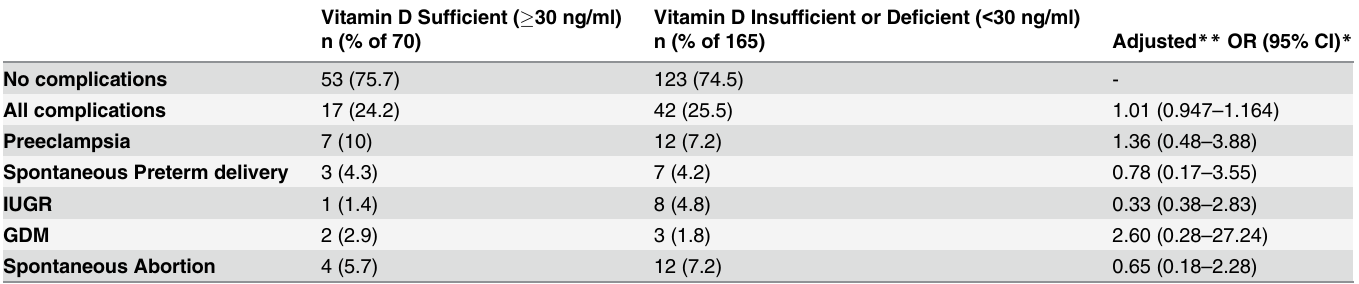
Table 5. Logistic regression analysis of clinical outcomes in women categorized as vitamin D sufficient compared to vitamin D insufficient or defi- cient